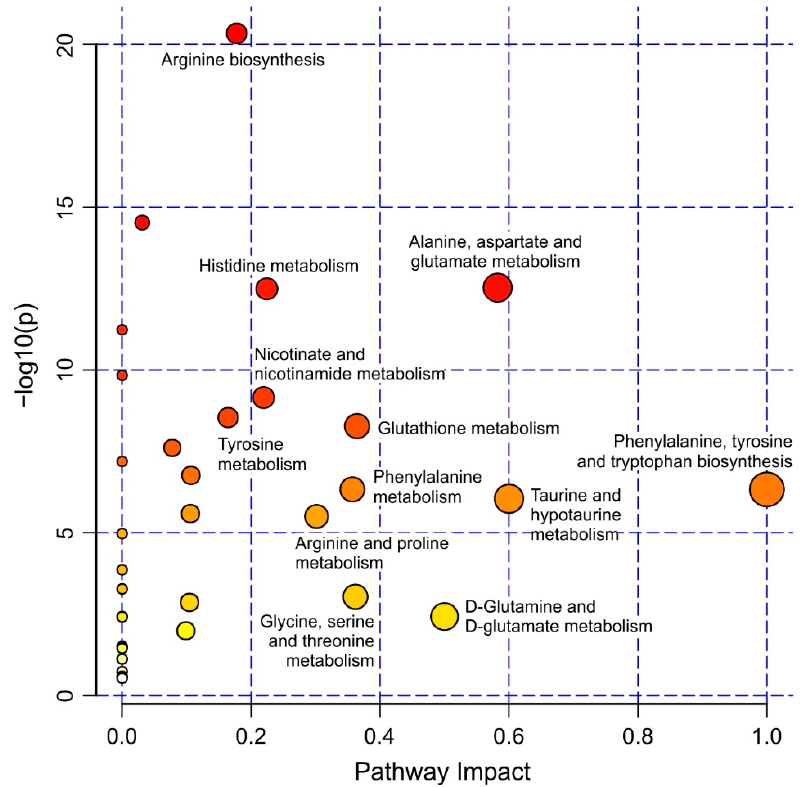
Figure 5. Pathway analysis revealing altered metabolic pathways between HO5 and iCab based on pathway impact score and p ‐ value. Pathways having pathway impact > 0.2 and − log( p ) > 2 were labelled. Pathway analysis was performed with the metabolites listed in Table S2.